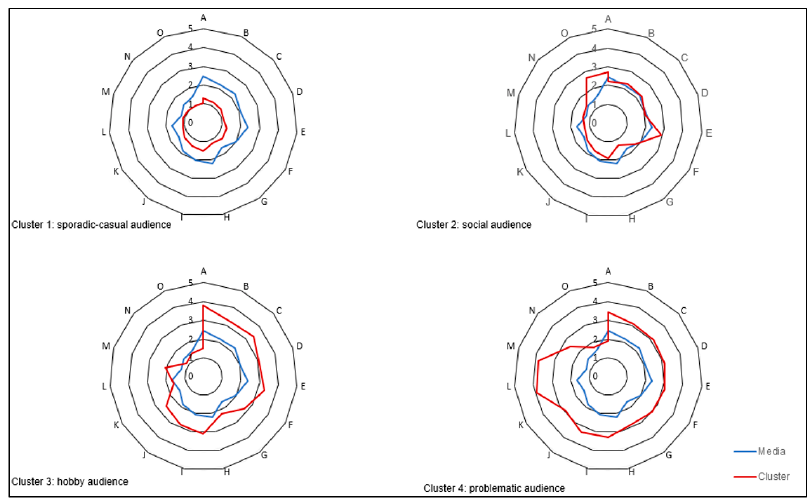
Figure 1. Profiles of gamer/viewer subgroups (the cluster is in red, the sample mean in blue). The tests for differences between means highlighted that belonging to a particular group has a significant relationship with the factors considered (recreational-informative, escapist-addictive, BM, and social: significant differences at the 0.05 level between the four measures, or at least in three), yielding four possible audience profiles: